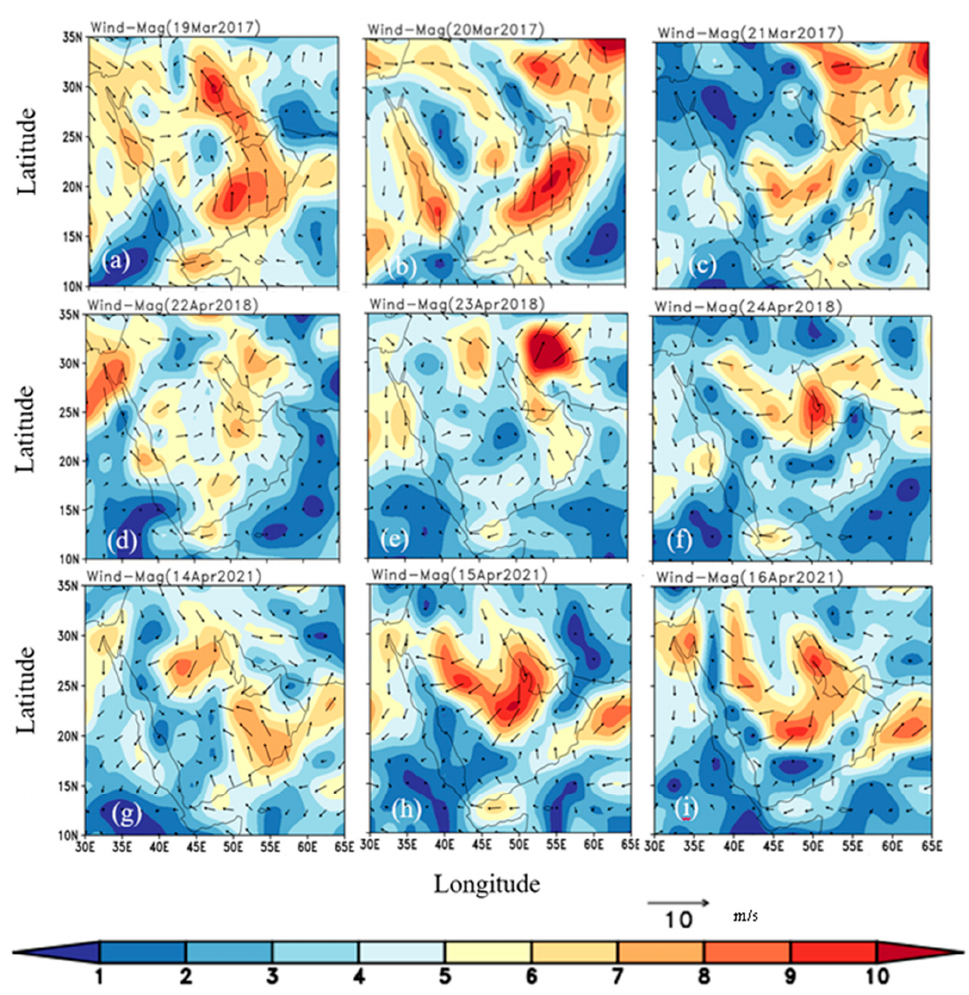
Figure 5. Wind speed and wind direction over Saudi Arabia during ( a – c ) 19–21 March 2017, ( d – f ) 22–24 April 2018; ( g – i ) 14–16 April 2021.